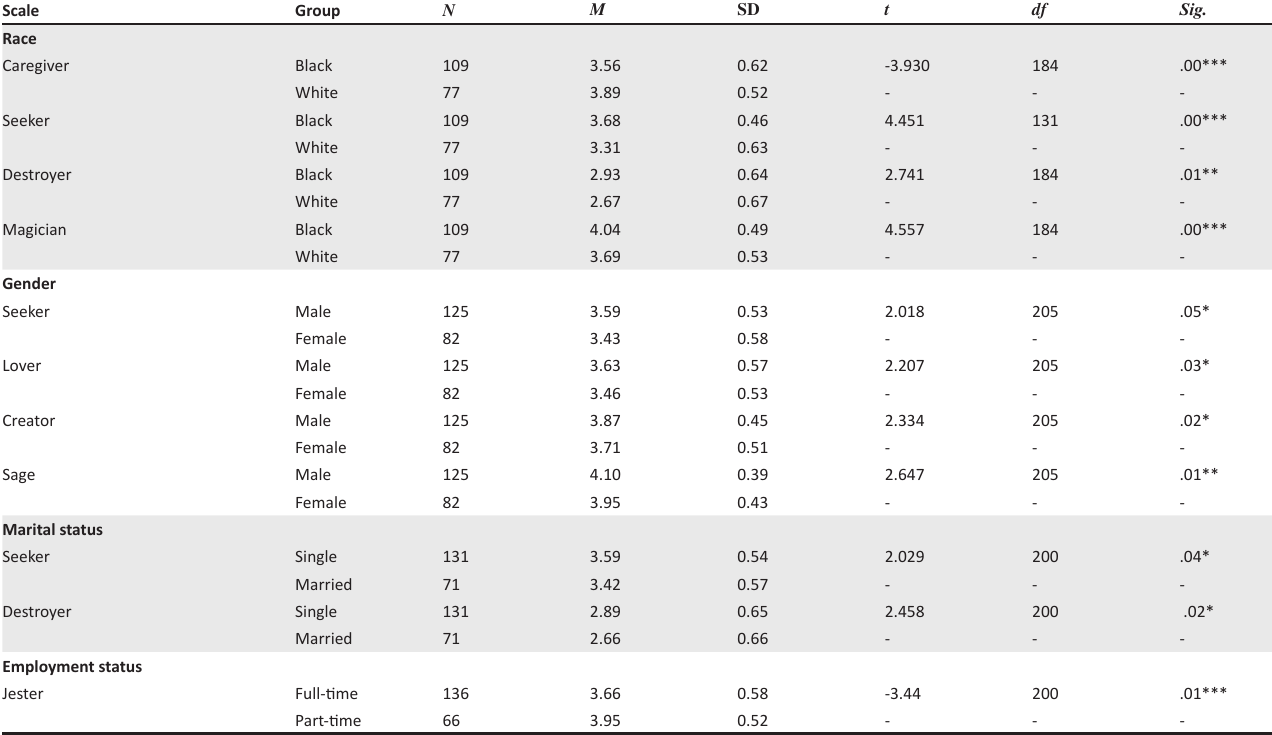
TABLE 5a: PMAI scale significant differences between race, gender, marital and employment status groups: Independent t -test results ( N = 207).